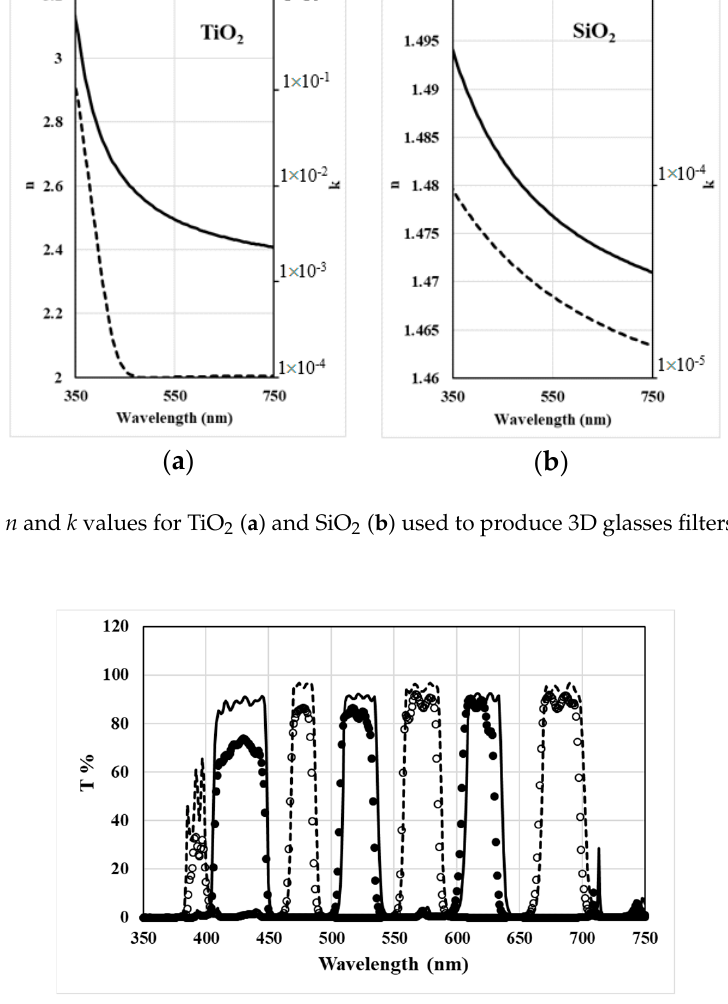
Figure 10. Transmittance of 3D glasses filters, solid line: side 1 design; solid circle: side 1 measurement; dotted line: side 2 design; open circle: side 2 measurement.